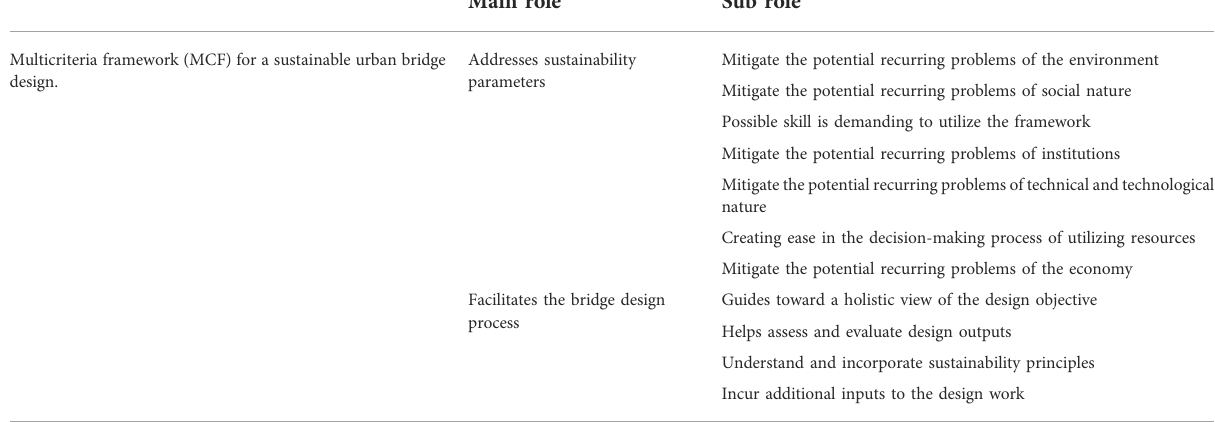
TABLE 10 Roles of MCF for the urban bridge